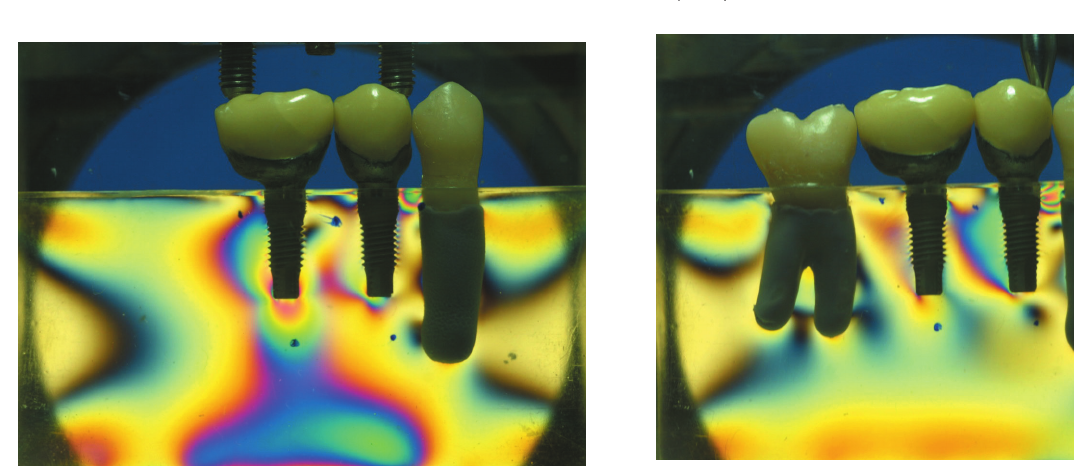
Figure 5- Simultaneous point load (10 kgf) on the second premolar and first molar (model without the second molar replica)